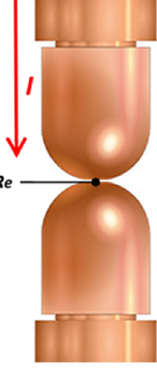
Figure 4. Schema—electrode resistance contact (Re) measurement.